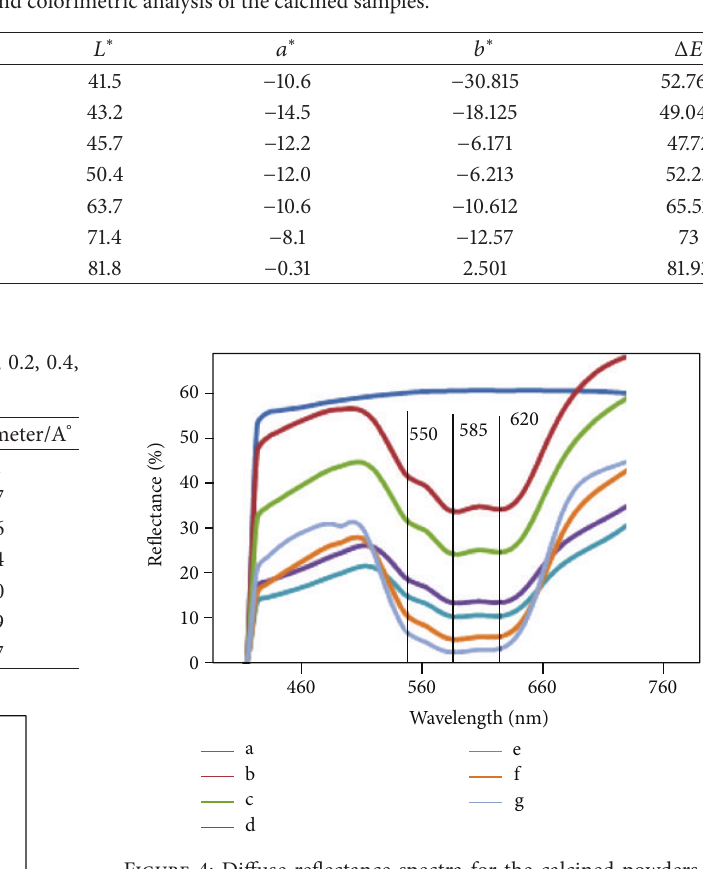
Figure 4: Diffuse reflectance spectra for the calcined powders of Mg 1− Al 2 O 4 { x = 0(a), 0.1(b), 0.2(c), 0.4(d), 0.6(e), 0.8(f), and Co x x 1(g) }